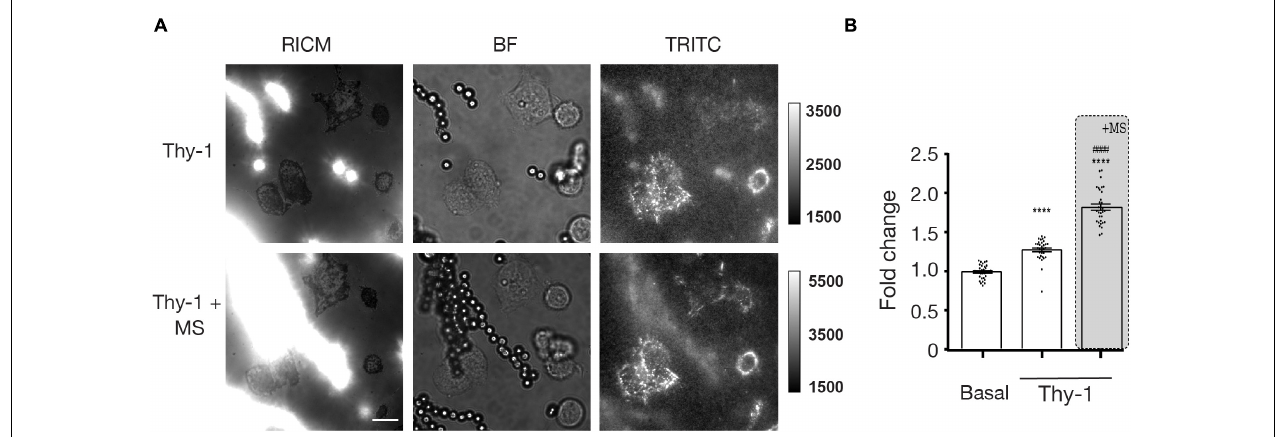
FIGURE 4 | Traction forces are increased after Thy-1 and mechanical stress stimulation in astrocytes. (A) Representative images of DITNC1 cells stimulated only with Protein A-magnetic beads coated with Thy-1 (top row) or with Thy-1-Protein A-magnetic beads plus mechanical stress (MS) (bottom row). The left column corresponds to Reflection Interference Contrast Microscopy (RICM), the middle column shows Bright Field (BF), and the right column, Total Reflection Internal Fluorescence of Traction Forces (TRITC). Magnification bar = 12 µ m (B) Quantification of mean fluorescence intensity measuring traction force for the basal, Thy-1 alone (for 5 min) and Thy-1 + mechanical stress (for 5 min) conditions (at least 30 cells per condition were counted). Values were normalized to the fluorescence intensity observed for cells without bead contact at the same time point for each condition (value + s.e.m. of three independent experiments). Statistical significance was calculated using the Kruskal–Wallis non-parametric test, with Dunn’s multiple comparison. **** p < 0.0001, compared with basal tension; #### p < 0.0001, compared with the tension corresponding to Thy-1